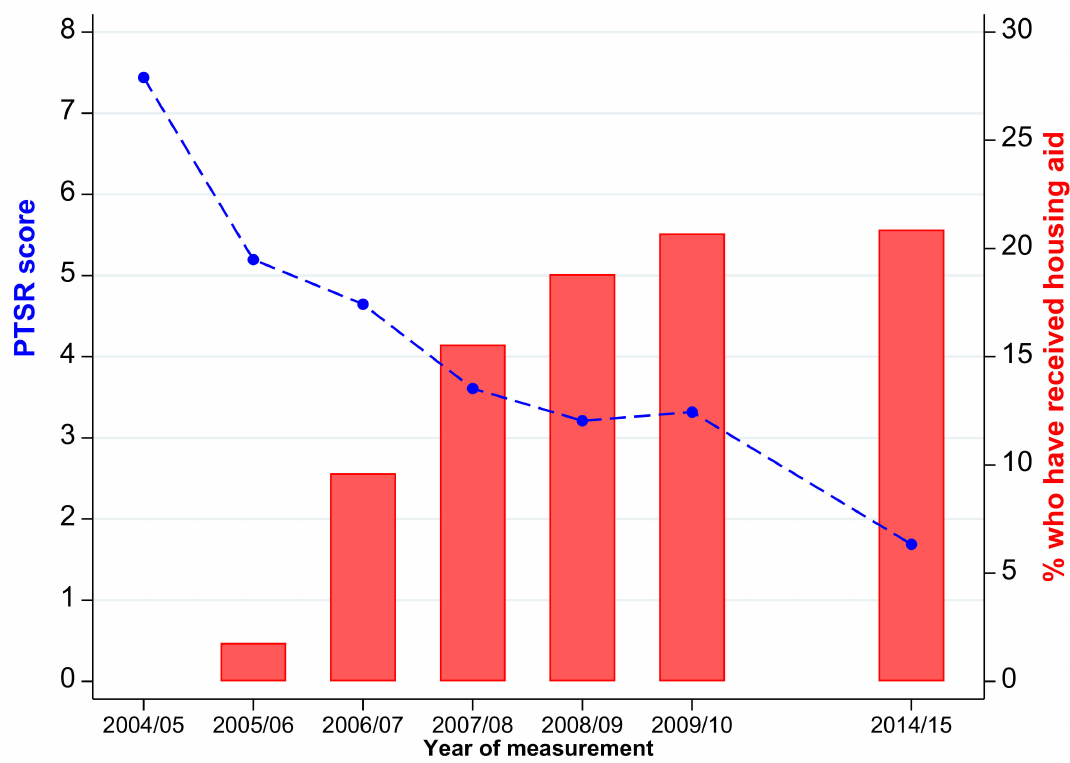
Figure 2. Evolution of PTSR and receipt of housing assistance in the ten years after the 2004 Indian Ocean